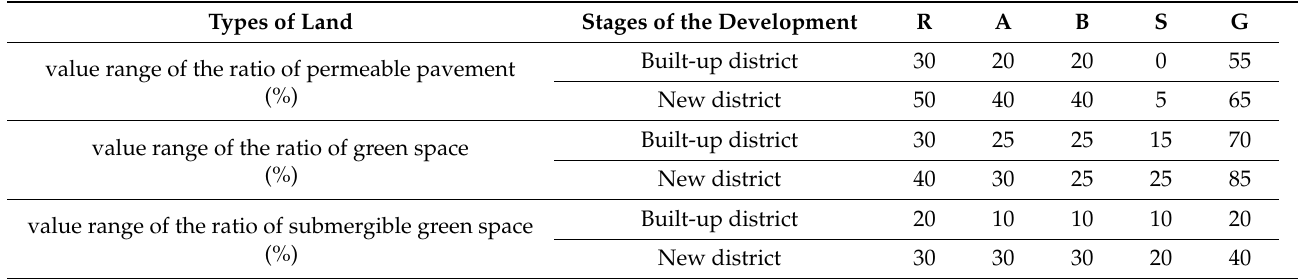
Figure 8. The map-based presentation of modeling results of land use indicators of M2. Table 5. Land use indicators of M2.